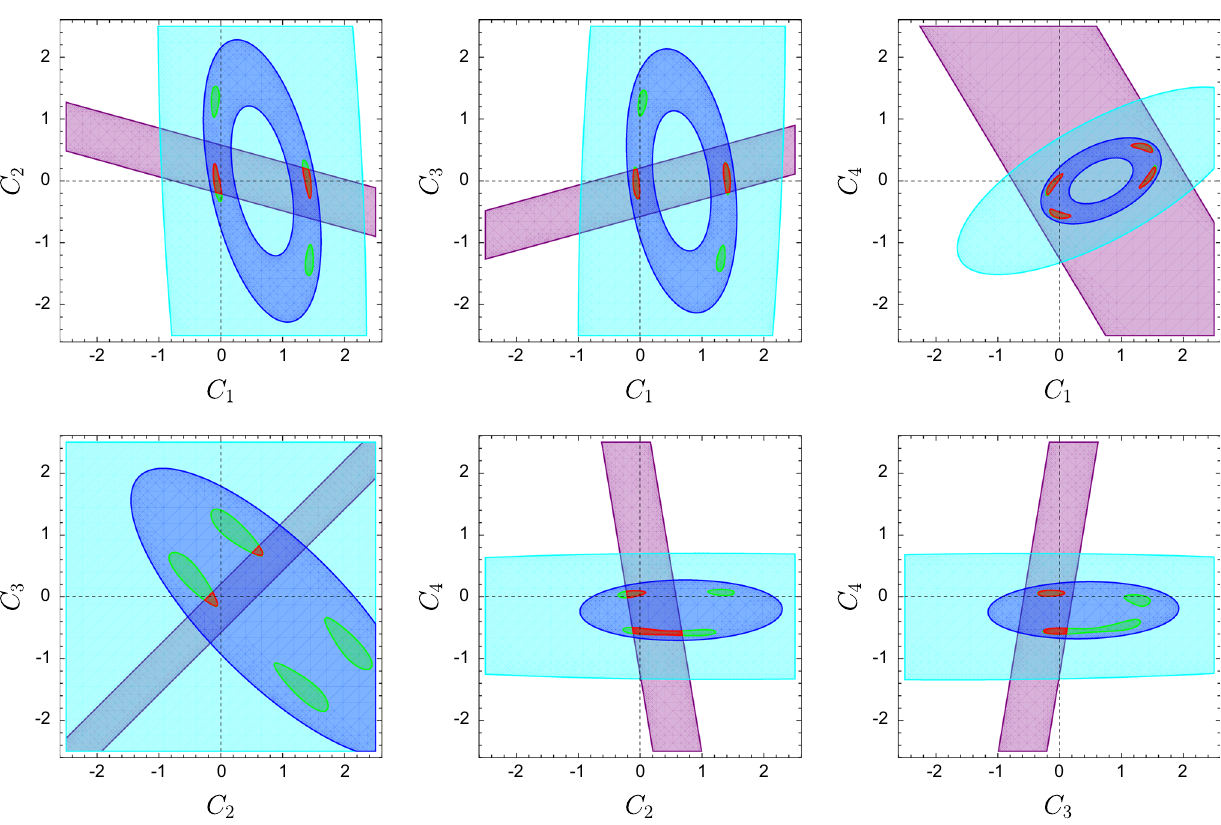
best-fit points given in Table 3, under the combined constraints from the measured R ( D ) , R ( D ∗ ) , P τ ( D ∗ ) , R ( J /ψ) , and R ( X c ) , being also compatible with the B ( B c → τν) (cid:2) 10% constraint. With such a treat- ment, all coloured areas (except the purple ones) correspond to 99 .